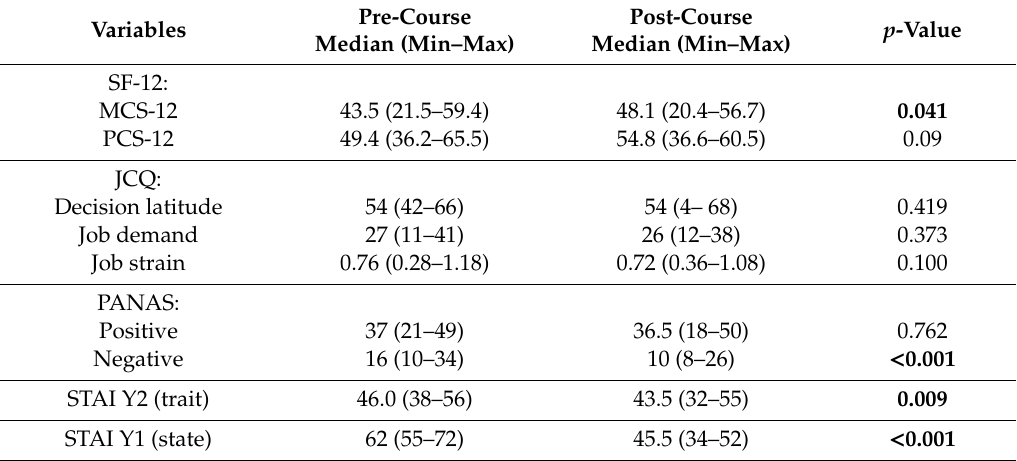
Table 2. Univariate analysis for the variables of interest: comparison pre-and